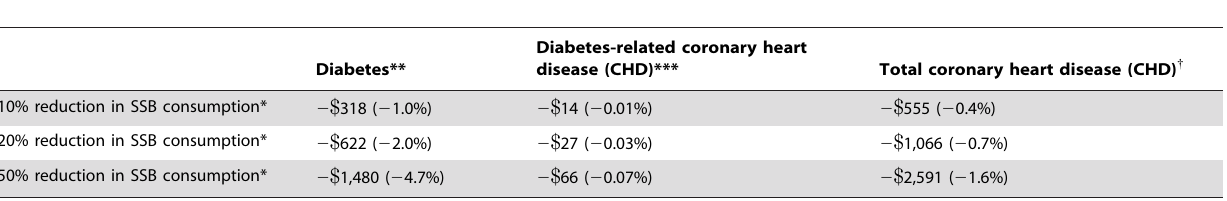
Table 5. Projected healthcare savings from 2013–2022 after a 10–50% SSB consumption reduction with a moderate BMI effect, in 2012 US dollars – in millions (Percent